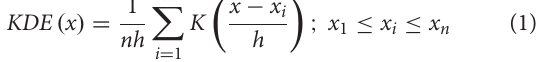
TABLE 6 | Compression of maximum error between experiment and simulation of window temperatures for the four cases on June 10, 2019. Window temperature ( ◦ C) Error (%) Case